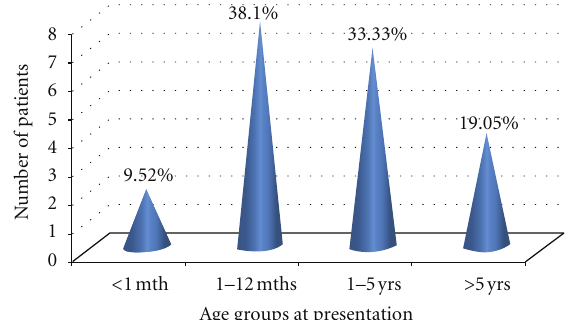
Figure 1: Age distribution of patients at presentation.